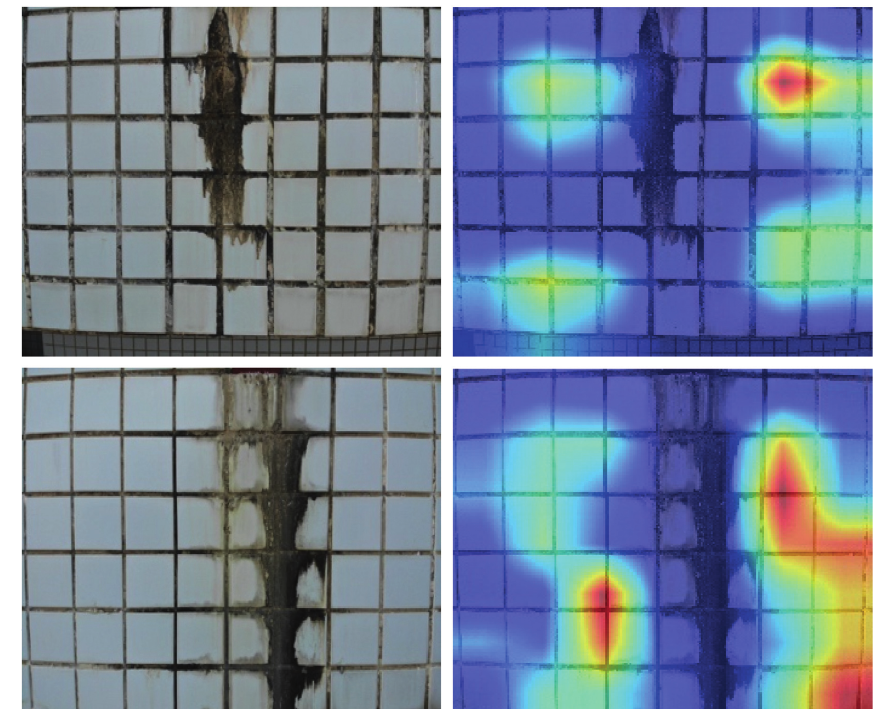
Figure 6: Defacement classified as spalling: comparison between original images and